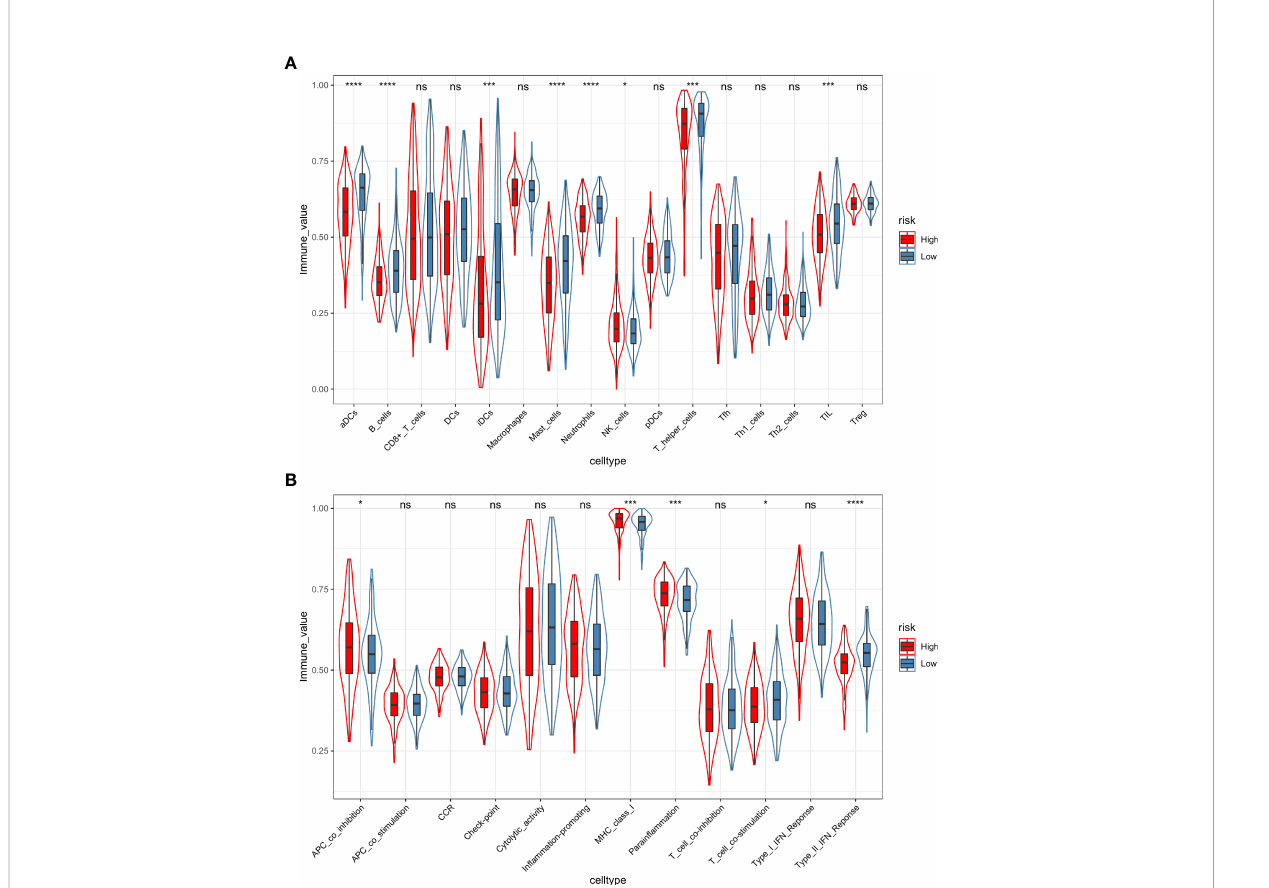
FIGURE 11 The ssGSEA algorithm was employed to quantify the immune cell in fi ltration (A) and immune function (B) between the high-risk and low-risk groups. *, p value < 0.05; ***, p value < 0.001; ****, p value < 0.0001; ns, not signi fi cant, p value >